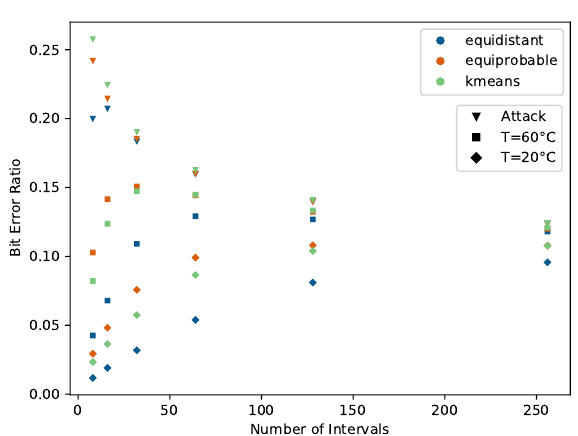
Figure 9: Bit Error Ratio for Gray Code mapping comparing temperatures T = 20° and T = 60° against a drilling